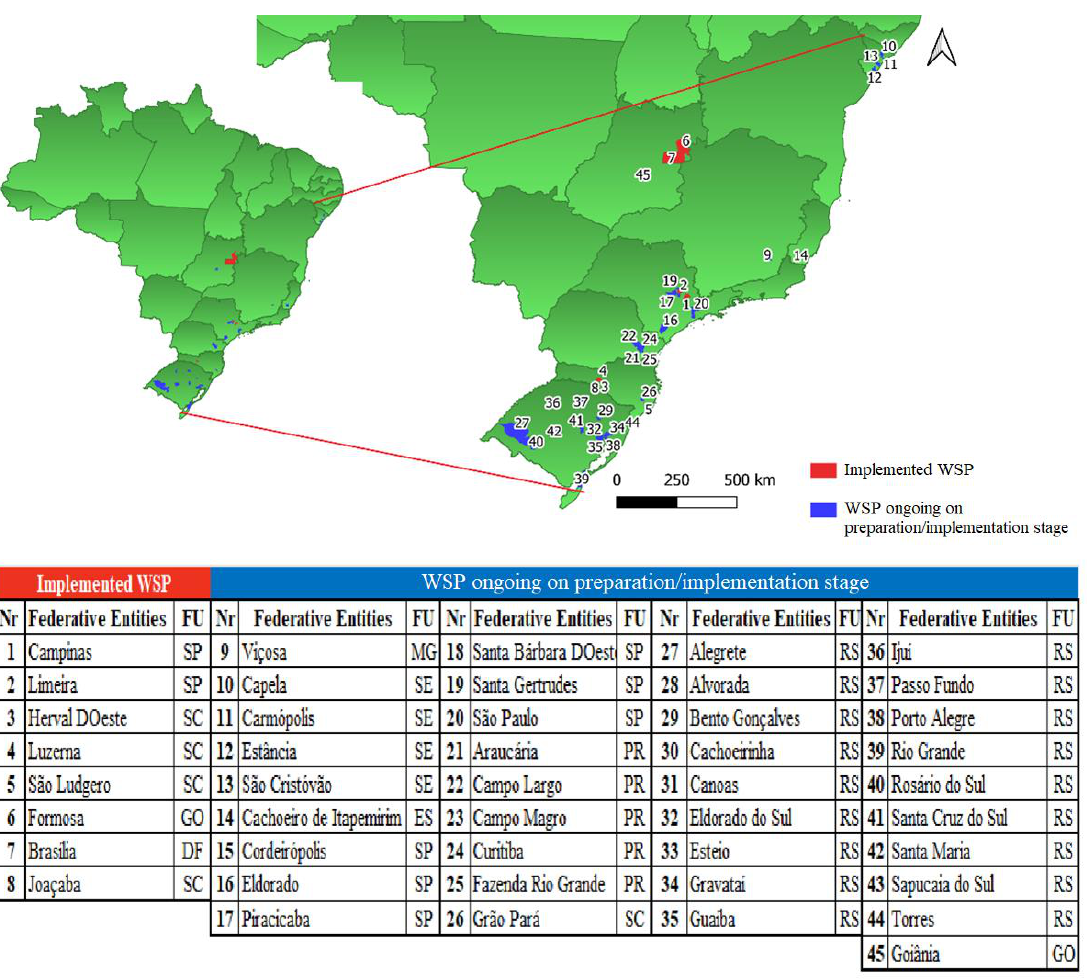
Figure 2. Federative entities with WSP under implementation or preparation (drafted by the author, data obtained from [21]).